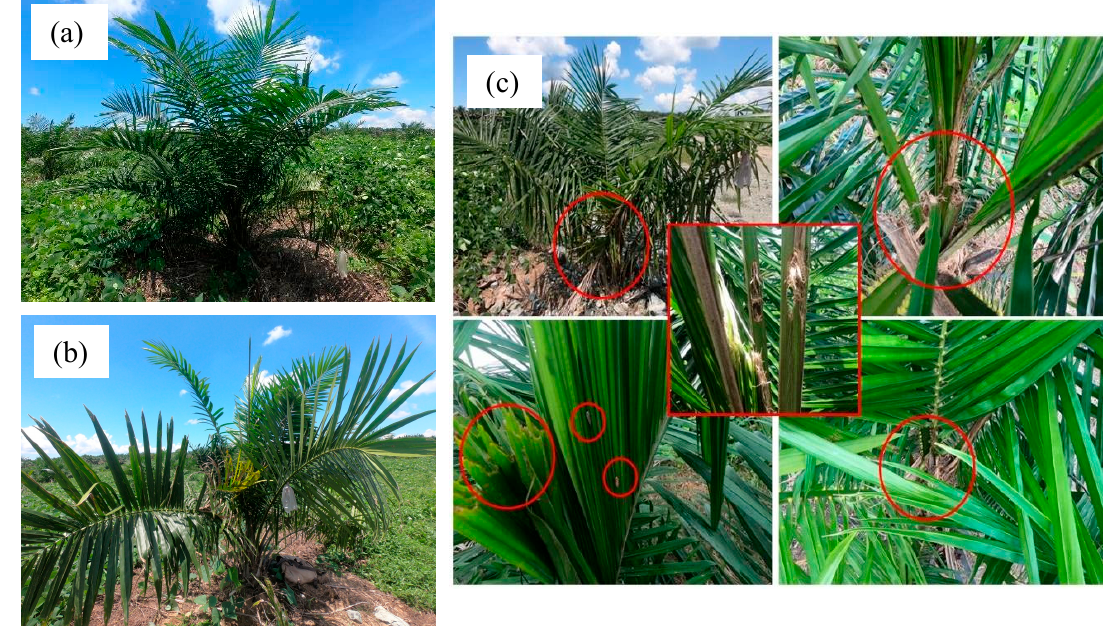
Figure 2. Field photographs of Oil palm: ( a ) Healthy tree, ( b ) diseased tree, and ( c ) damaged tree due to the rhinoceros beetle ( Oryctes Rhinoceros L.) and other pests.